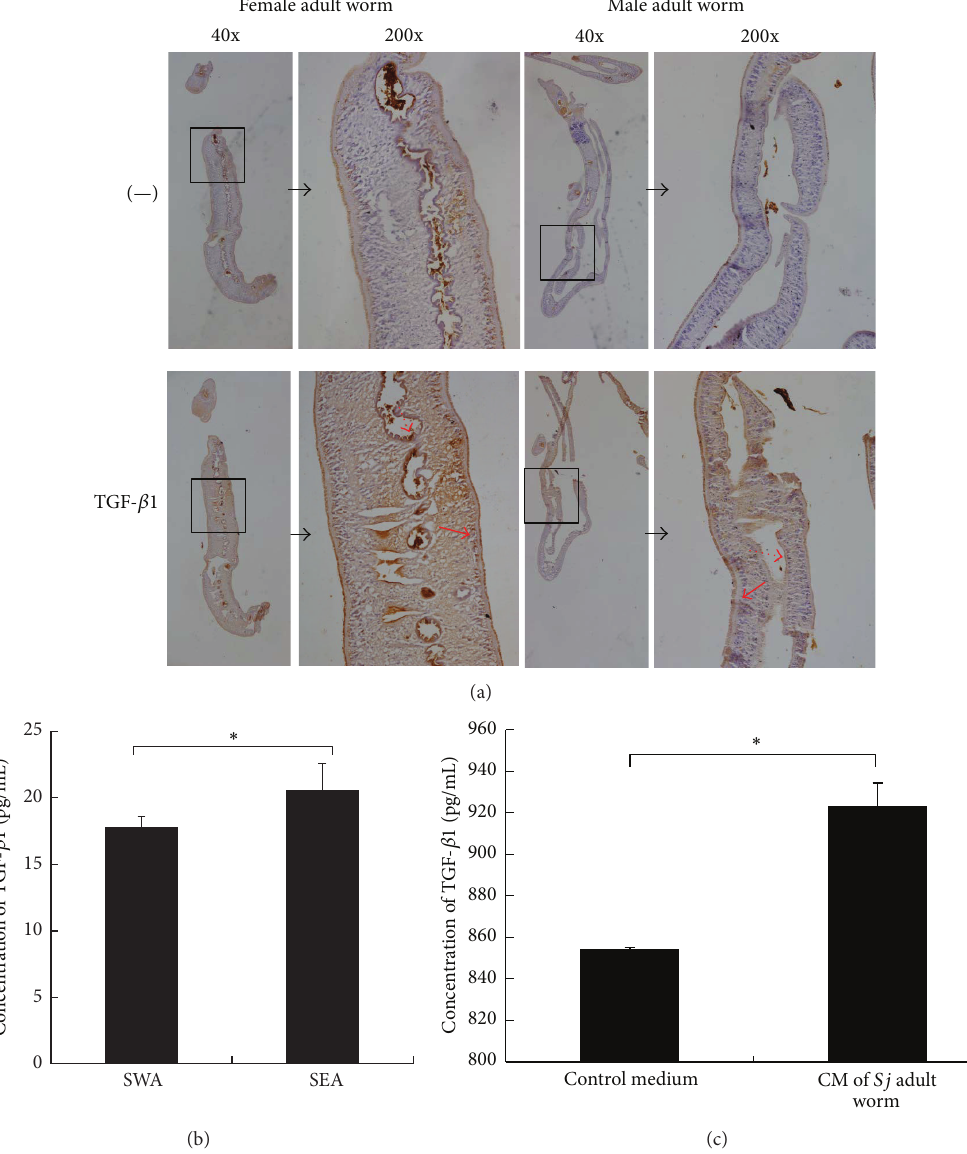
Figure3:TGF- 𝛽 1proteinwasexpressedin Sj andwassecreted.(a) Sj adultfemaleandmalewormswerefixedinparaformaldehyde,embedded in paraffin, and then sliced and stained for TGF- 𝛽 1. Representative staining (brown) is shown at 40x magnification (large panel) and × 200 (inset). Dotted red arrow: gut epithelial cells; solid red arrow: subtegumental cells. (b) Equal amounts of Sj soluble adult worm antigen and soluble egg antigen were tested for TGF- 𝛽 1 by ELISA. Data were shown as means ± SD. Experiment was performed four times ( ∗ 𝑃 < 0.05 ; and ∗∗ 𝑃 < 0.01 compared with negative PBS control). (c) Twenty pairs of adult worms were freshly collected, washed thrice using PBS, transferredinto2mLsterileRPMI1640mediumsupplementedwith1mMglutamine,1000units/mLpenicillin,and1000 𝜇 g/mLstreptomycin for 2h, and finally cultured in 2mL sterile RPMI 1640 medium supplemented with 20% FBS, 1mM glutamine, 100 units/mL penicillin, and 100 𝜇 g/mLstreptomycinfor16h. Sj wormculturemediumwascollectedforTGF- 𝛽 1detectionbyELISA,andconditionmedium(sterileRPMI 1640 medium supplemented with 20% FBS, 1mM glutamine, 100 units/mL penicillin, and 100 𝜇 g/mL streptomycin) was used as control. Experiment was performed four times ( ∗ 𝑃 < 0.05 ; and ∗∗ 𝑃 < 0.01 compared with control medium without Sj adult